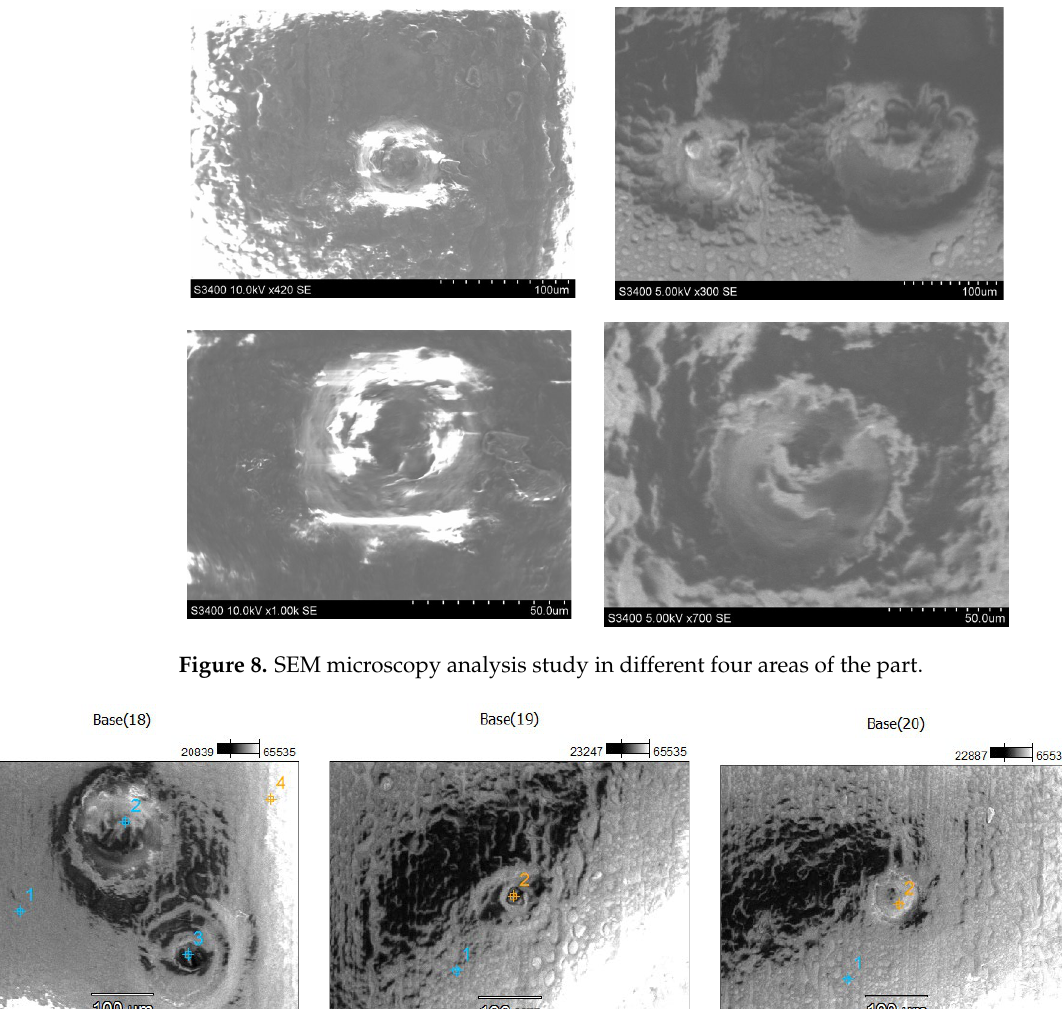
( c ) ( d ) ( b ) Figure 7. Coated parts analysis: ( a ) Visual test; ( b ) Optical microscopy analysis of the rectangle window of the part; ( c ) Optical microscopy analysis on the upper zone of the rectangle window; ( d ) Optical microscopy analysis on the right zone of the rectangle window. The results of adhesion test have shown a good bonding over all parts selected in the experiments, the level of evaluation being zero—Level 1 with very good bonding, and no traces from the cut paint on the tape. The result of the thickness test shows that it is not related to the “fish-eye defects” on